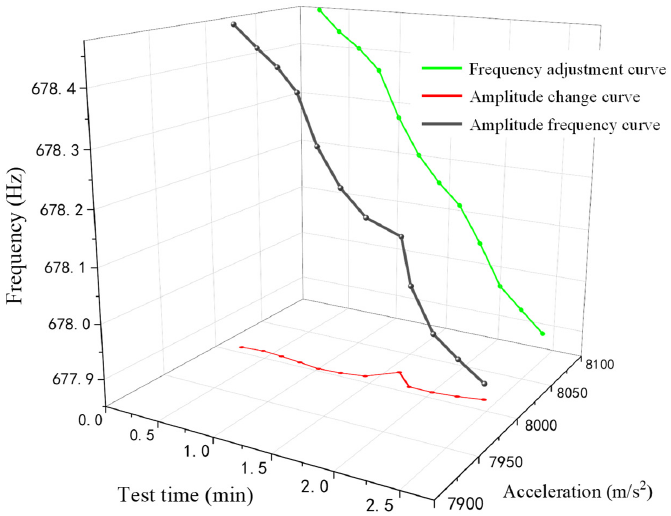
Figure 15. Schematic diagram of phase tracking amplitude control in the 8000 m/s 2 interval.